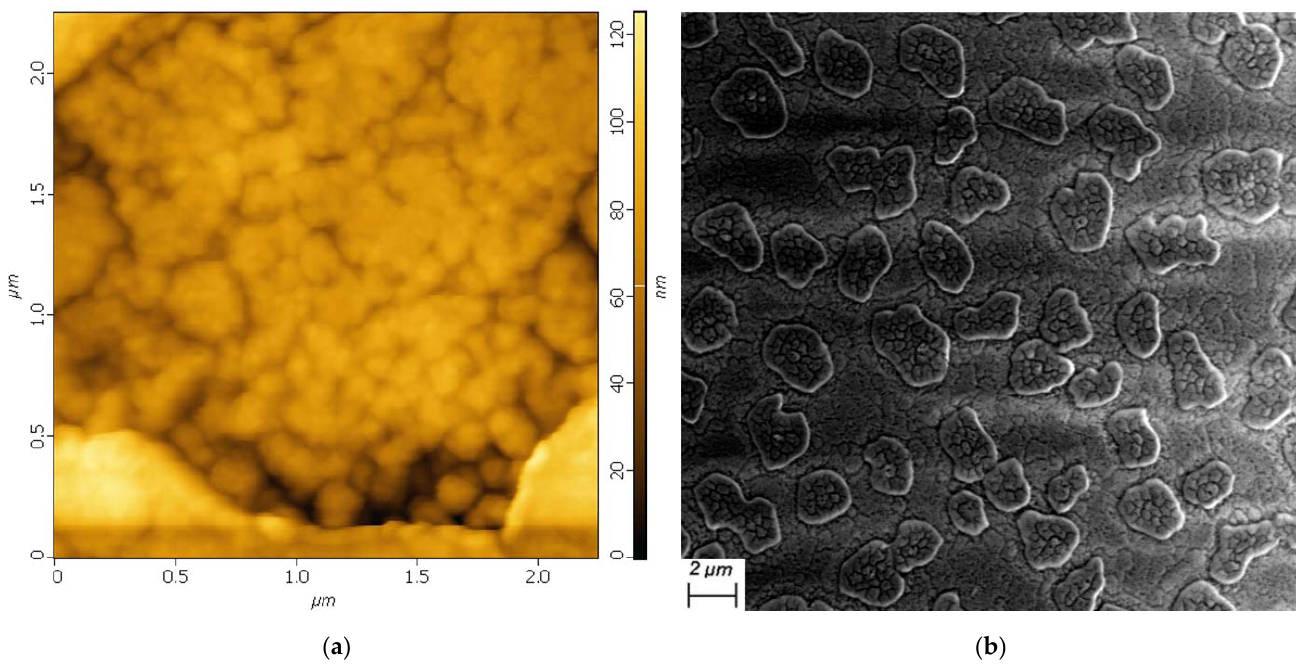
Figure 3. AFM image of the surface of pristine SubPzS 3 H 0 film (V-metallized) in a scan window of 2.25 × 2.25 μ m 2 ( a ), and SEM image of this surface in a window of 25 × 25 μ m 2 ( b , nonmetallized). The lower part of the AFM image displays the edge of a large surface object that is seen in SEM—inset.